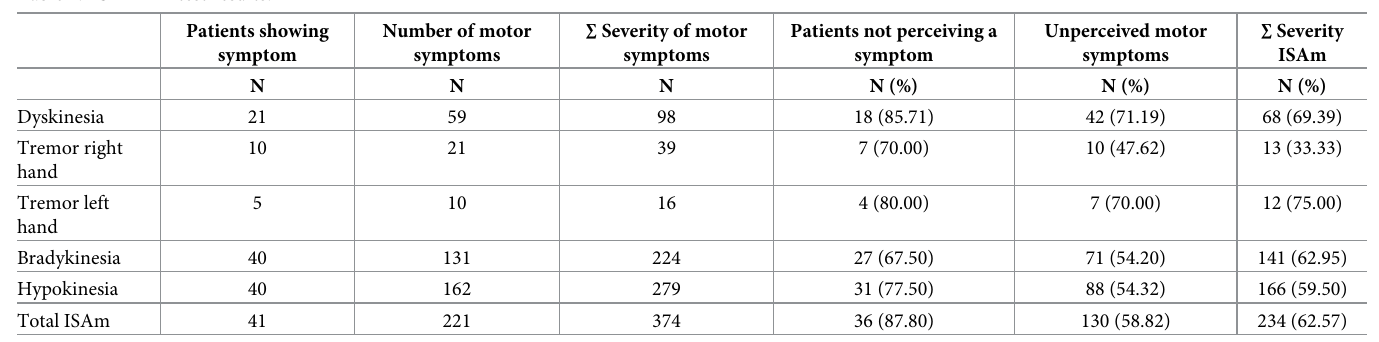
Table 4. ISAm-PD test results.